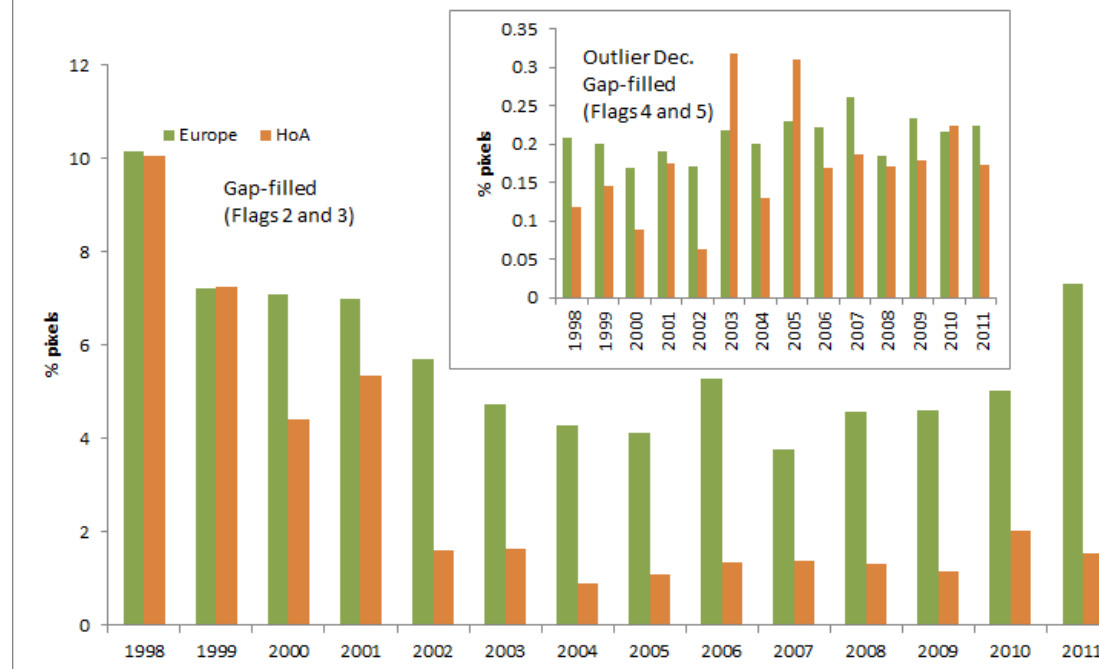
Figure 8. Frequency of Flag 2 and Flag 3 ( i.e. , only the gap filling is applied) and Flag 4 and Flag 5 ( i.e. , both the gap filling and the outlier decontamination are applied) occurrences over Europe (green bars) and over the Horn of Africa (orange